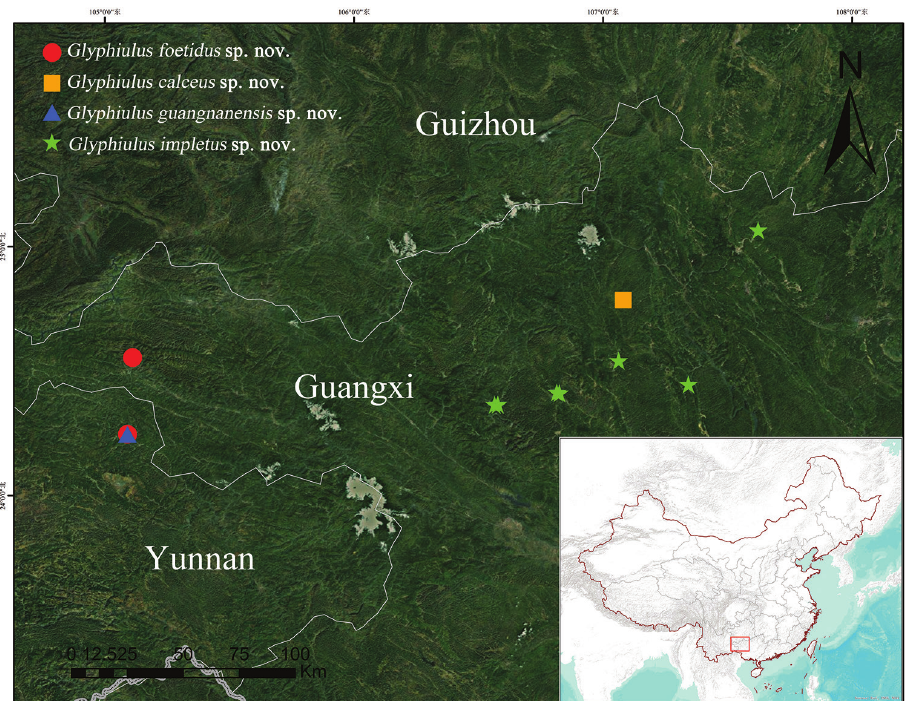
Figure 22. Distributions of Glyphiulus foetidus sp. n., Glyphiulus calceus sp. n., Glyphiulus guangnanensis sp. n. and Glyphiulus impletus sp. n.